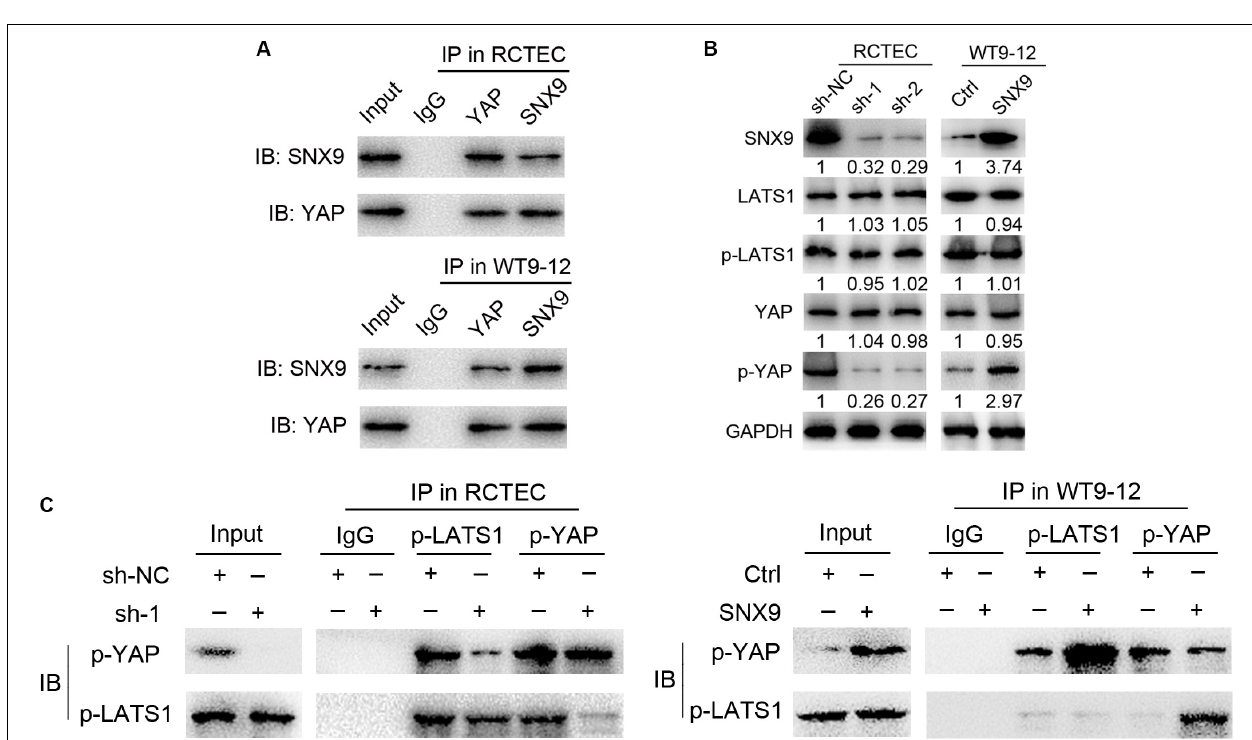
FIGURE 5 | SNX9 inhibits ADPKD progression via the activation of the Hippo signaling pathway. (A) SNX9-depleted RCTEC and control cells were treated with the YAP/TEAD4 inhibitor verteporfin (1 µ M/L) or DMSO for 24 h. Then, the indicated protein levels were assayed by western blot analysis. (B) SNX9-depleted and control RCTEC cells were subjected to verteporfin (1 µ M/L) or DMSO treatment for 24 h. Then the indicated cells were subjected to EdU incorporation assay. Data are presented with scatterplots and mean values, n = 5. **Indicates P < 0.01; ***indicates P < 0.001 by Student’s t -test. (C) SNX9-depleted and control MDCK cells were subjected to verteporfin (1 µ M/L) or DMSO treatment for 24 h. Then three-dimensional cultures using collagen matrix, with or without verteporfin (1 µ M/L) were used to develop a renal cyst formation model. The percentage of cyst formation and the cyst diameters of the indicated cells were shown. Data are presented with scatterplots and mean values, n = 3. **Indicates P < 0.01; ***indicates P < 0.001 by Student’s t -test.